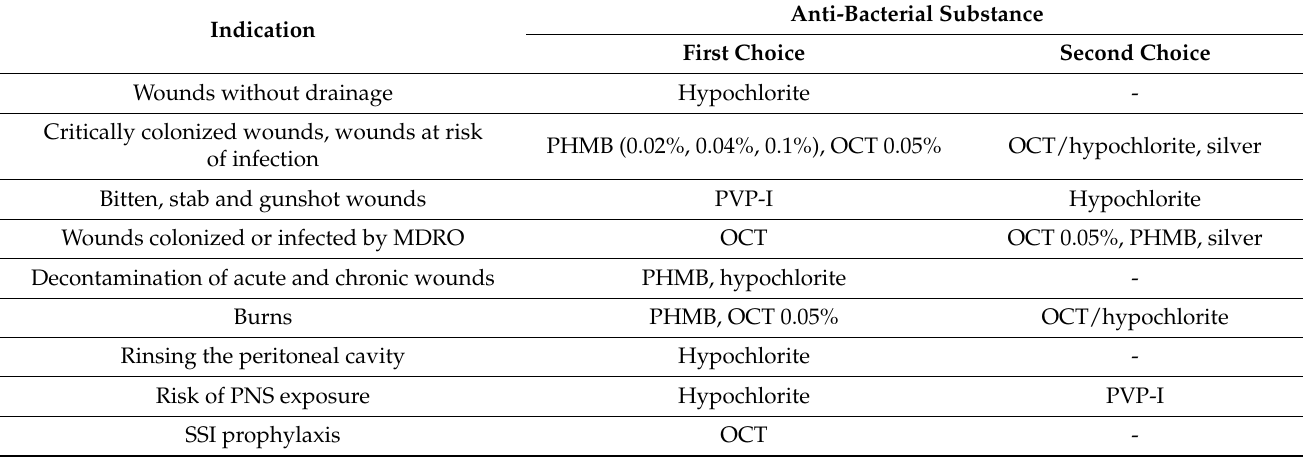
Figure 1. Antiseptics recommended according to the German Consensus and Polish Guidelines for the treatment of specific wounds [28–30] . Table 2. Summary of first and second choice measures for the treatment of specific wounds [28–30] .